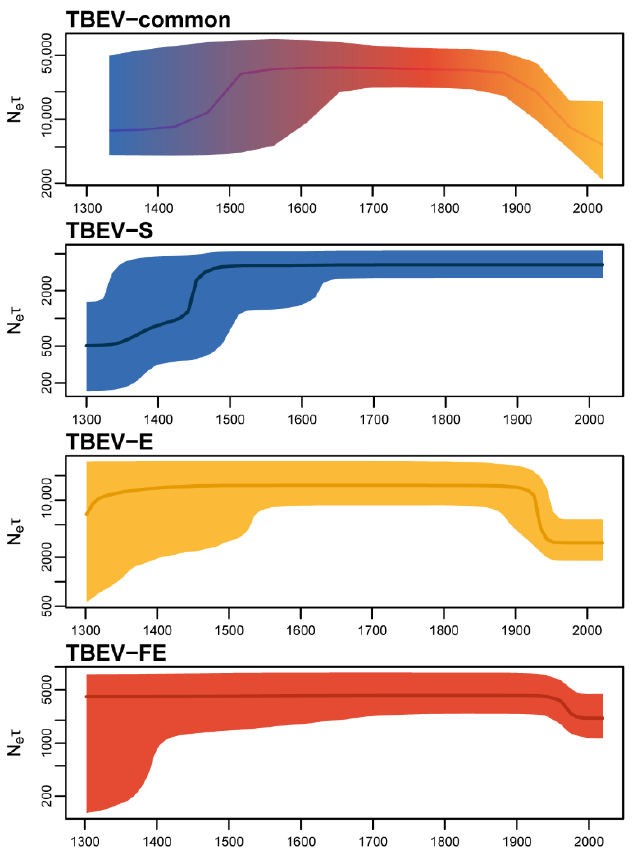
Figure 6. Population dynamics of the common clade of tick-borne encephalitis virus (TBEV-common), TBEV Siberian subtype (TBEV-S), European subtype (TBEV-E), and Far-Eastern subtype (TBEV-FE). The log Y-axis indicates relative genetic diversity—N e × τ , where N e is an effective population size or in the context of infectious diseases it is the effective number of infections [17], τ is the generation time or time between successive infections in transmission chains. The solid lines are median values, filled areas are 95% highest posterior density (HPD) intervals. To reconstruct the population dynamics of TBEV-S, we applied substitution rate estimates obtained during the analysis of TBEV-common. The gradient fill of TBEV-common displays features in the N e × τ trend shared with the other TBEV subtypes.